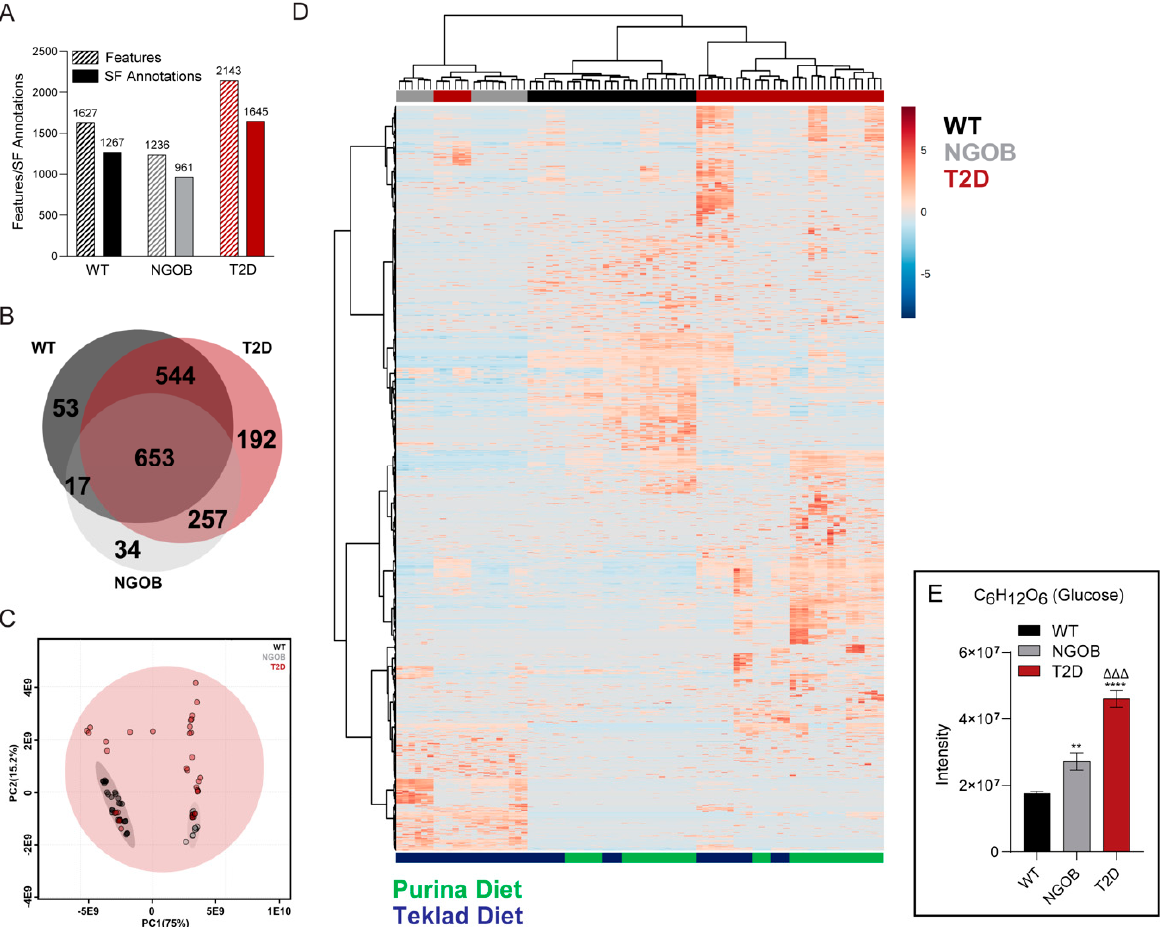
Figure 5. Application of flow injection electrospray (FIE)-Fourier Transform Ion Cyclotron Resonance (FTICR) mass spectrometry (MS) to plasma samples from WT, NGOB, and T2D mice: ( A ) the numbers of features (light shading) and chemical formula annotations (solid shading) from MetaboScape 4.0 ( ∆ m < 5 ppm) of the WT, NGOB, and T2D groups; ( B ) Venn diagram of chemical formula annotations of WT, NGOB, and T2D plasma samples; ( C ) Principal component analysis (PCA) of the three groups based on FIE-FTICR MS data, where the 95% confidence limit is indicated as the shaded area; ( D ) heat map of significantly expressed metabolic features annotated by a chemical formula generated by unsupervised hierarchical clustering analysis; and ( E ) intensity of the hexose peak, experimentally confirmed to be primarily glucose, in WT, NGOB, and T2D plasma. Data represent mean ± SEM and were compared by one-way ANOVA with Holm-Sidak test post hoc. ** p < 0.01 and **** p < 0.0001 compared to WT. ∆∆∆ p < 0.001 compared to